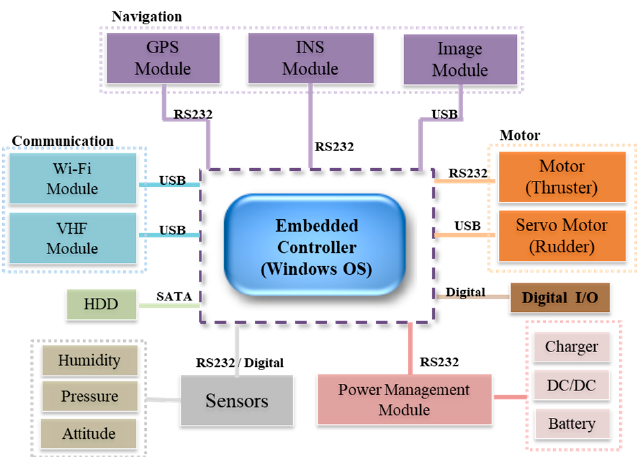
Figure 2. Block diagram of the embedded system.